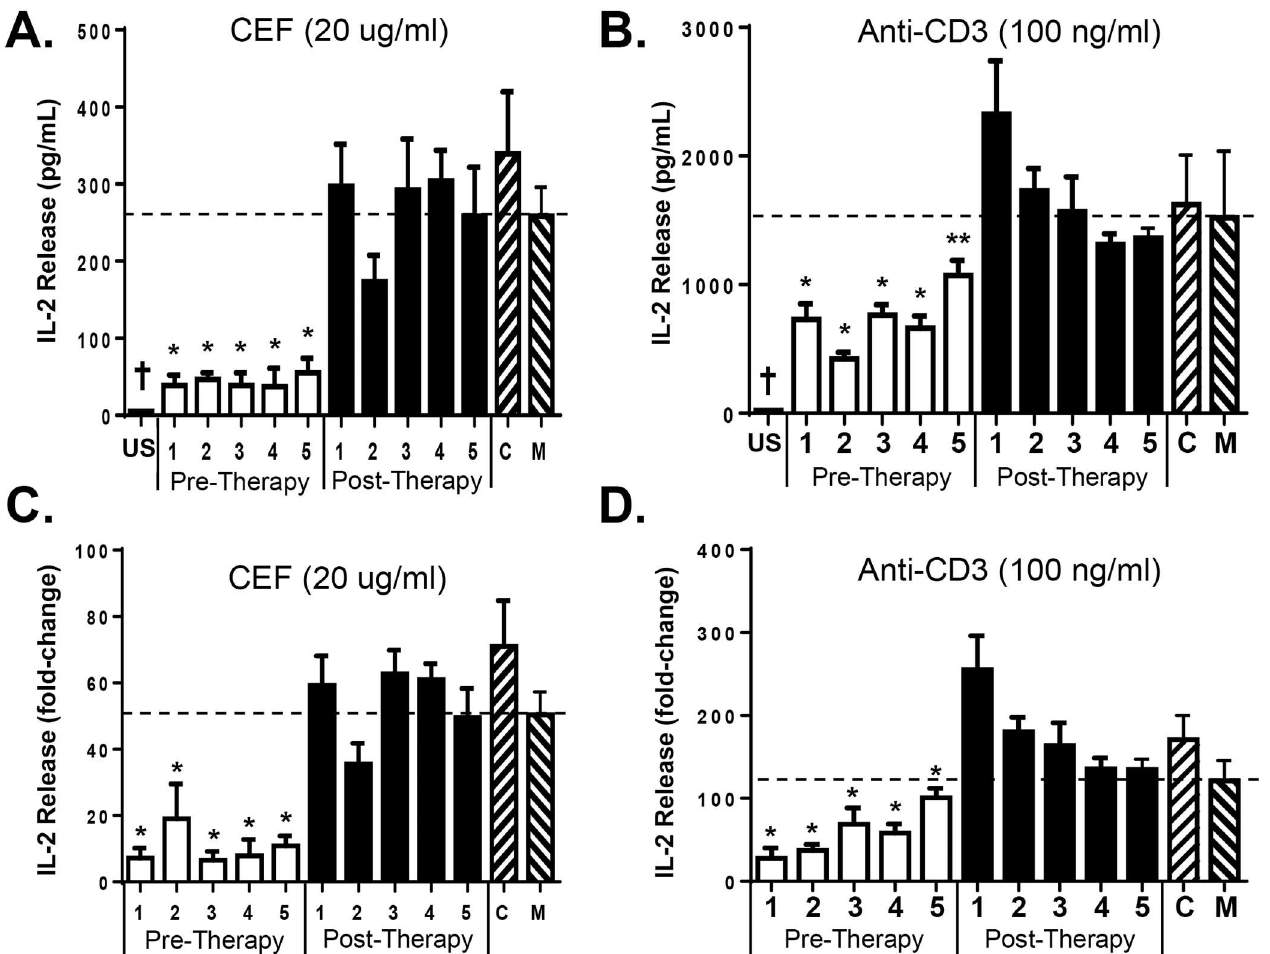
Fig 1. HCV RNA-containing sera inhibit antigen-specific and anti-CD3-mediated T cell receptor signaling. Healthy donor PBMCs were incubatedin serum obtained before or followingcurative HCV therapy for 24 hrs, stimulatedwith a pool of antigenicpeptides from CMV, EBV, and influenzavirus (CEF; A) or anti-CD3(B), and IL-2 measured16 hrs later. US = unstimulated. C = control, these cells were incubatedin serum pooledfrom five HCV-uninfected individuals.M = no serum control. * p < 0.01, ** p < 0.05 comparedto post-treatment samplesand controls, † US vs. all other samples. Data in panels A and B representresults from three replicates in a singledonor. Experiments were repeated in two additional healthydonor PBMCs and the combinedfold-change in IL-2 release for all three donors followingCEF (C) or anti-CD3 (D) for the same sera samples is